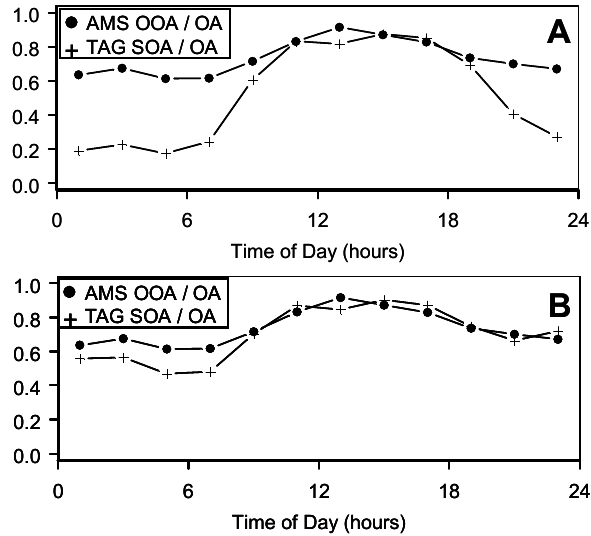
Fig. 14. (A) Average diurnal plots of AMS oxygenated organic aerosol (OOA) fraction of total OA (circles) and TAG secondary OA (SOA) fraction of total OA (plus symbols), with SOA defined as the sum of only SOA1, SOA2, and SOA3 PMF components. (B) Same as previous figure, except now including SOA4+SV with the three previous TAG SOA